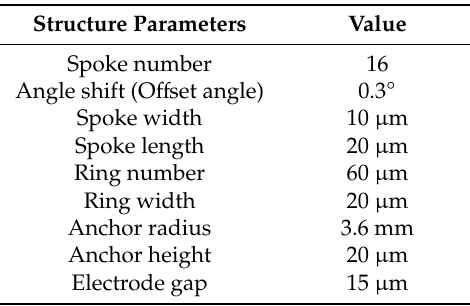
Table 3. Structure parameters of the